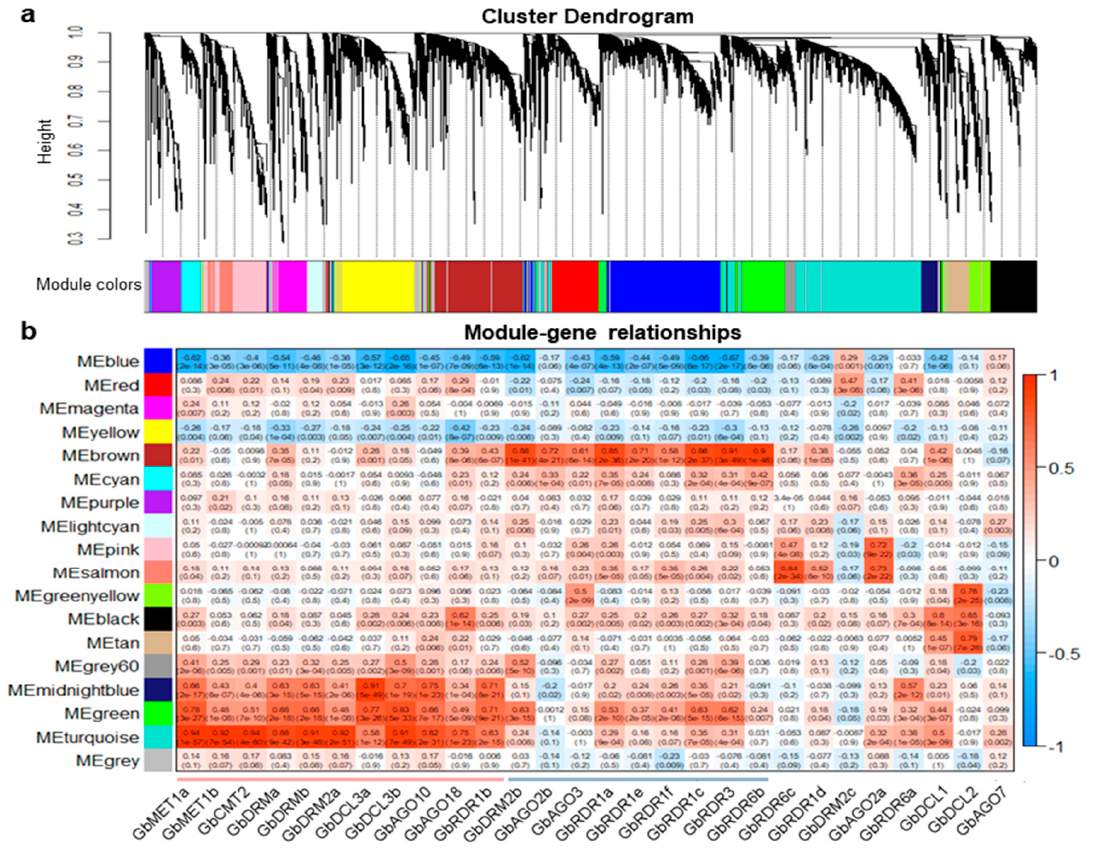
Figure 6. Weighted gene co-expression network analysis (WGCNA) of DNA methylation pathway genes. ( a ) Expressed genes were assigned to 18 modules, and ( b ) the correlation between each module and individual DNA methylation genes. Pink line and blue line indicate group I and group II genes, respectively.